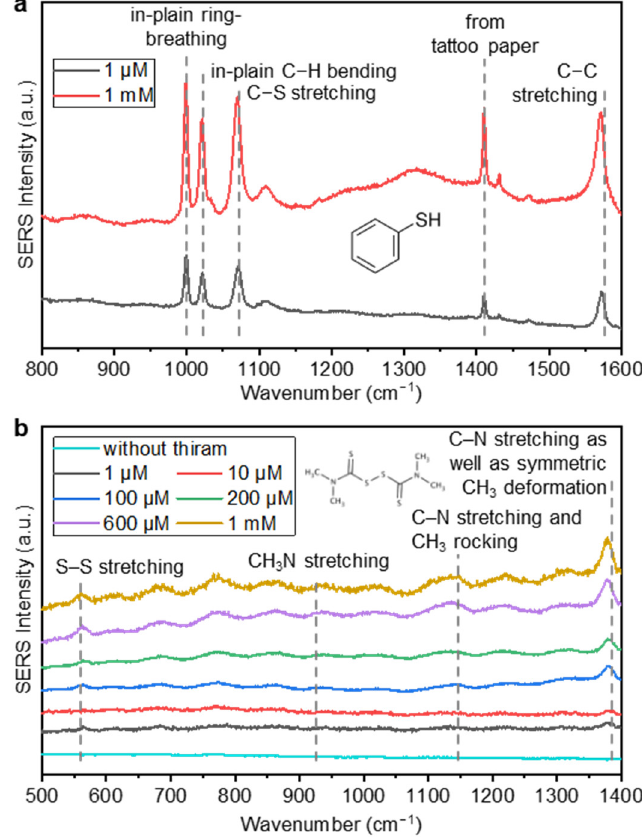
Figure 5. ( a ) SERS intensities at 999, 1022, 1072, 1410, and 1574 cm − 1 , which were measured during the identification of the 1 µ M and 1 mM concentrations of benzenethiol solutions; and ( b ) SERS intensity spectrum without thiram and with thiram at concentrations of 1, 10, 100, 200, and 600 μM and 1 mM, exhibiting peak identification at 560, 933, 1144, and 1382 cm −1 for all the concentrations.